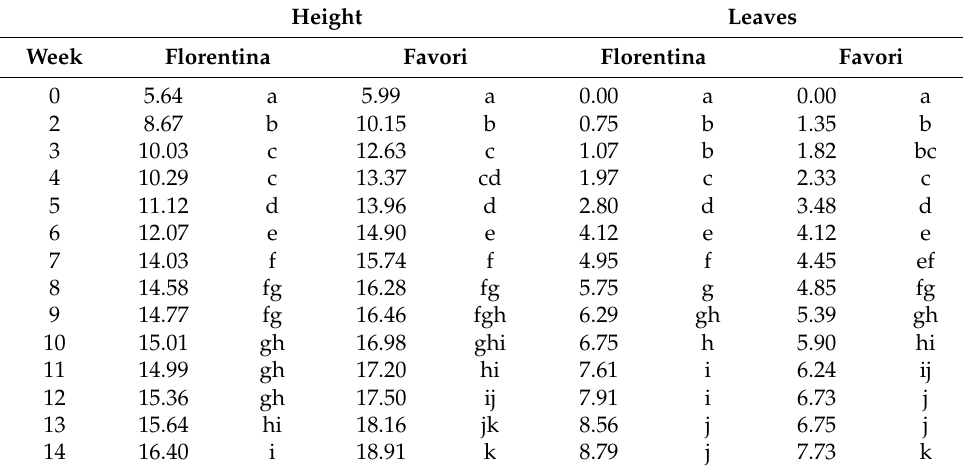
Table A6. Mixed effects linear regression model for the LD treatment within the cultivars ‘Florentina’ and ‘Favori’, respectively, for the plant height and total number of leaf measurements taken during the 14 weeks under the LD treatment (N = 29–32). The least square means followed by the same lowercase letter did not differ statistically by the Tukey test at 5% of error probability ( p < 0.05). Height